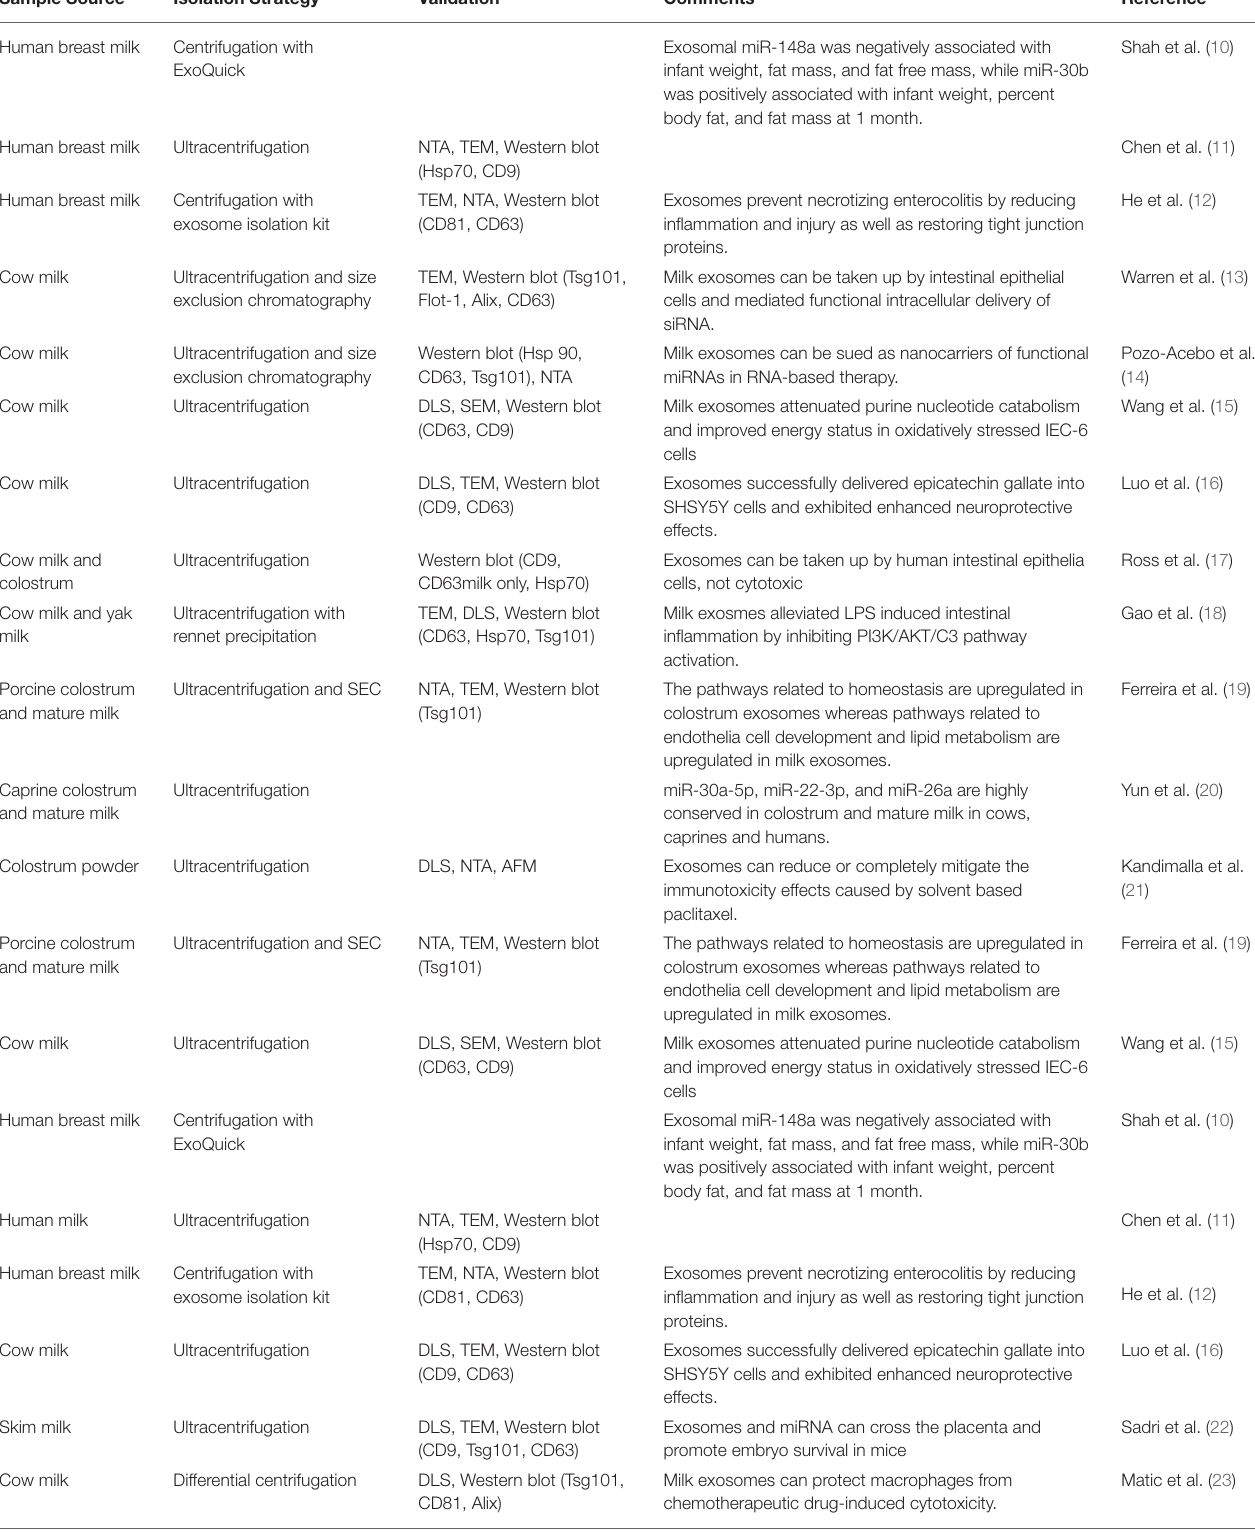
TABLE 1 | Summary of the isolation and validation techniques of milk derived exosomes in literature published since